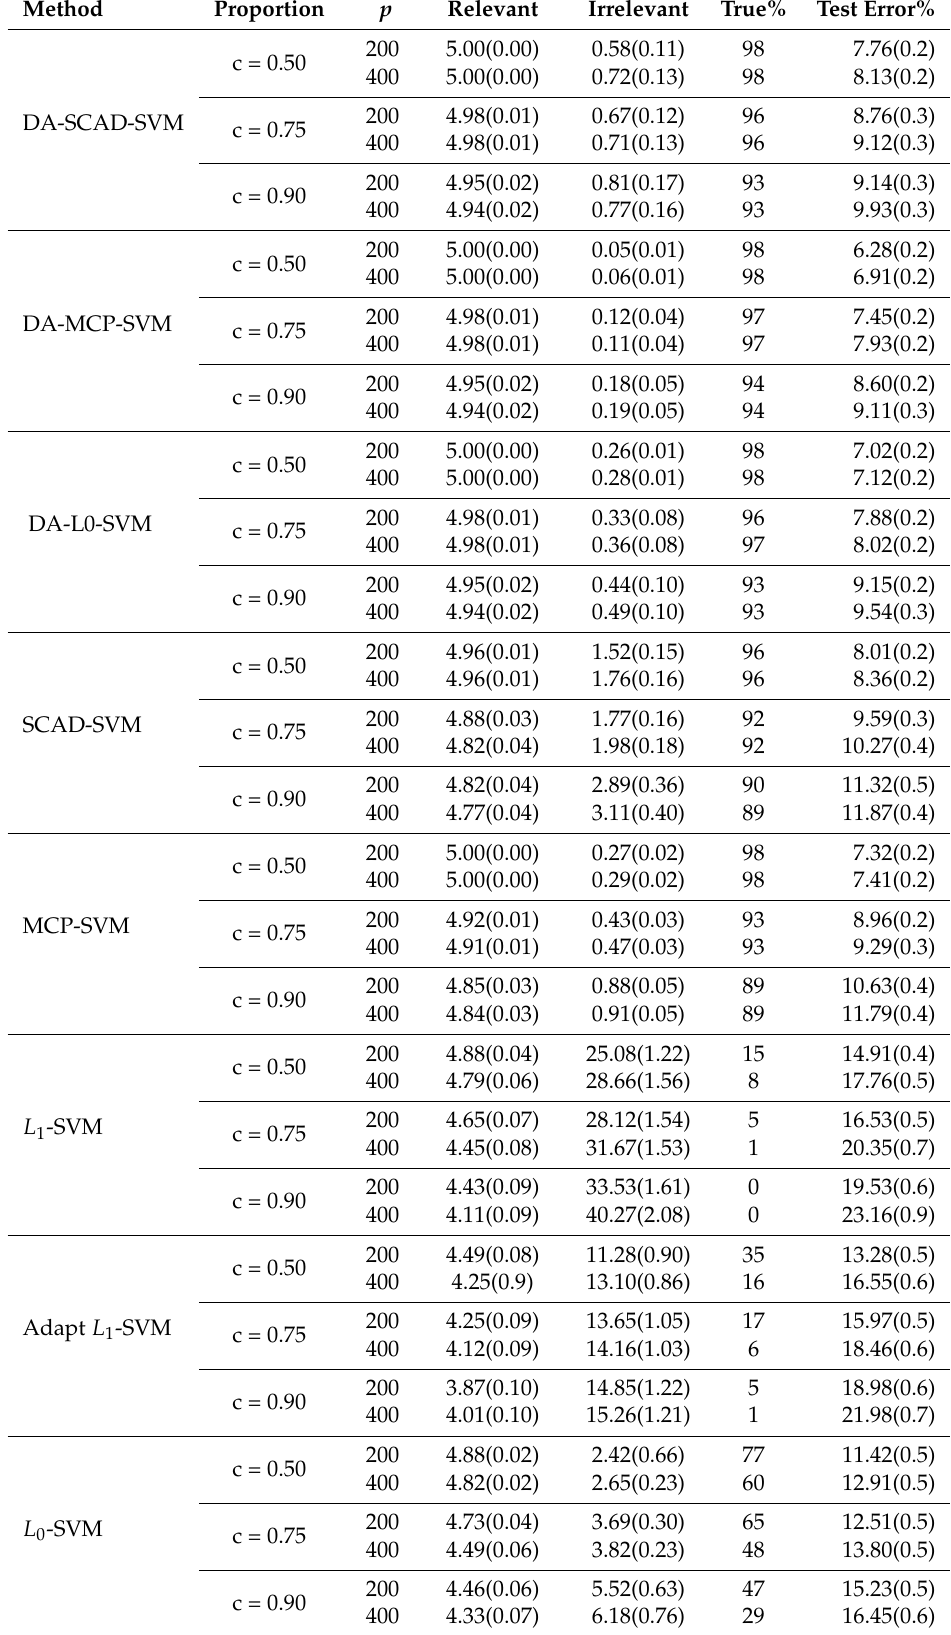
Table 2. Simulation study outcome where the sample size n = 400. Margins are provided in